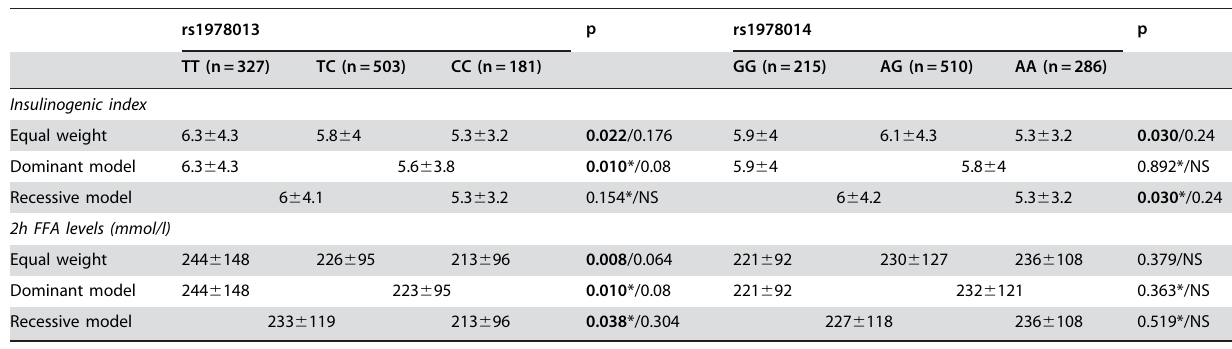
Legend to Table 4. n=1011. Data are mean 6 SD. Asterisk (*) indicates results from linear regression analysis, adjusted for age, sex, BMI and family dependence. Both nominal and the Bonferroni-corrected p-values are shown. NS: not significant.